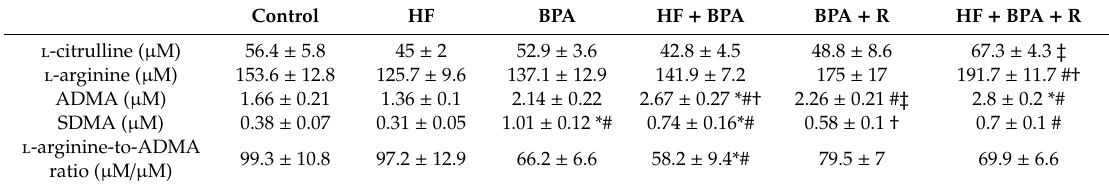
Table 2. Plasma levels of NO-related elements in di ff erent experimental groups.